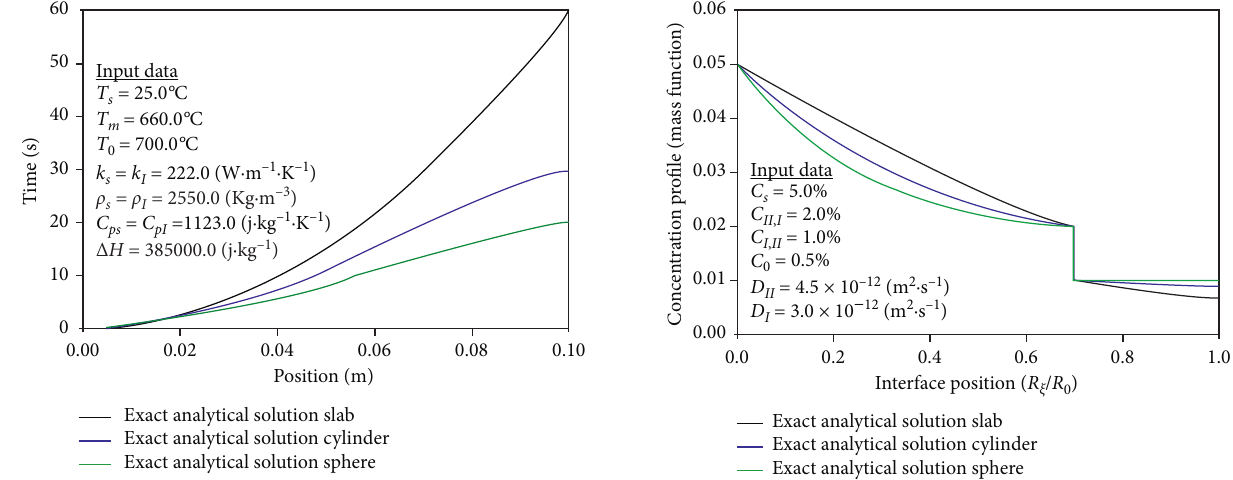
) at 30% of R / R . ξ 0 0